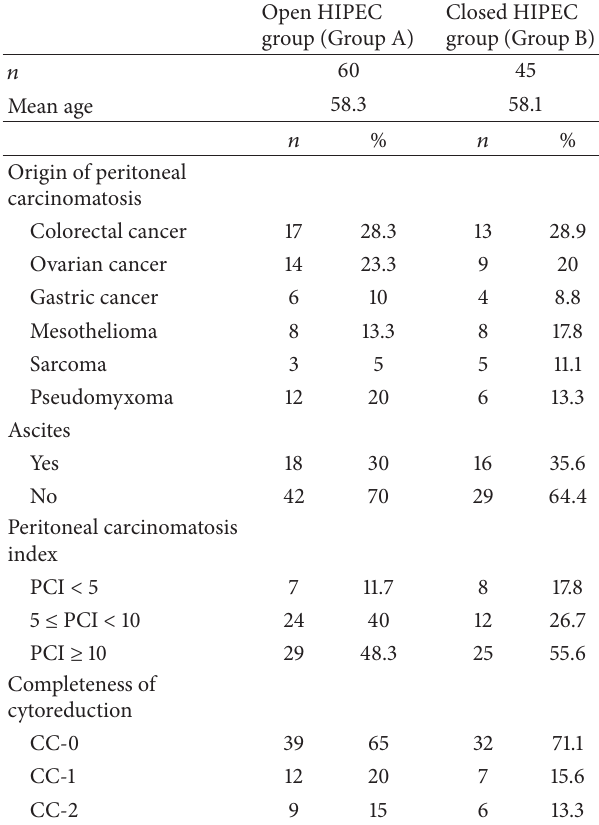
Table 1: Patient characteristics, 𝑛 = 105